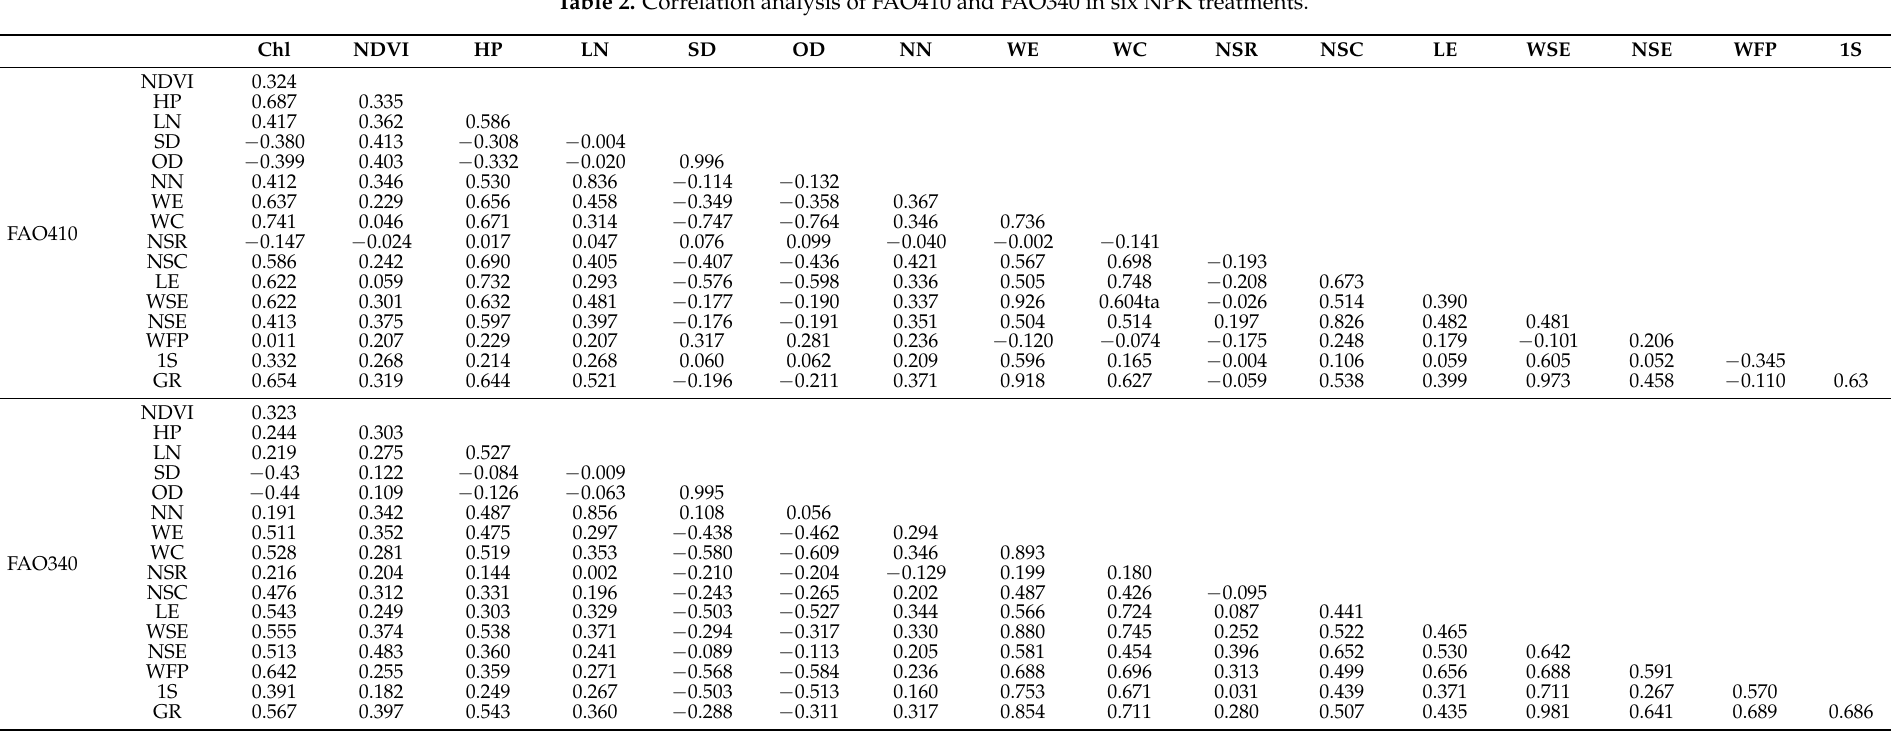
Table 2. Correlation analysis of FAO410 and FAO340 in six NPK